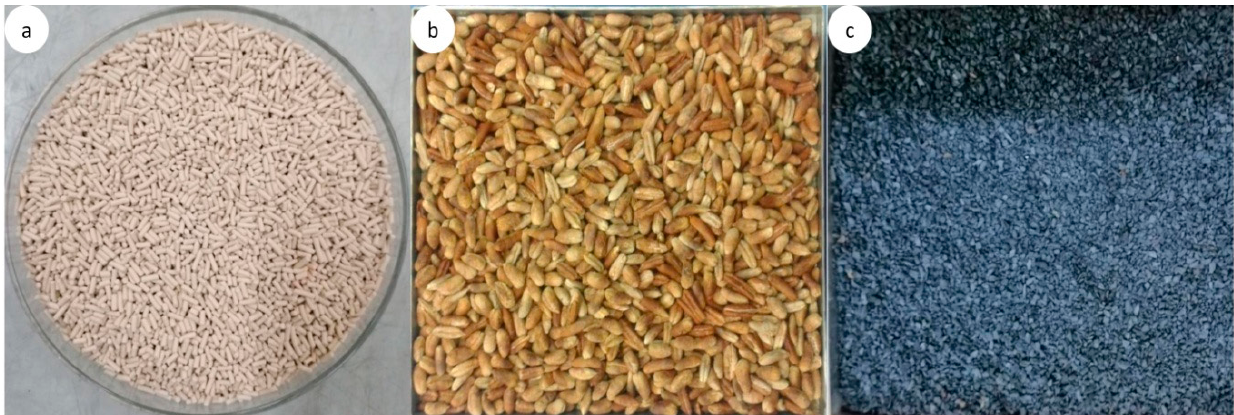
Figure 2. ( a ) MS 3Å, and ( b ) oven-dried date pits and ( c ) produced porous activated carbon AC-SY.